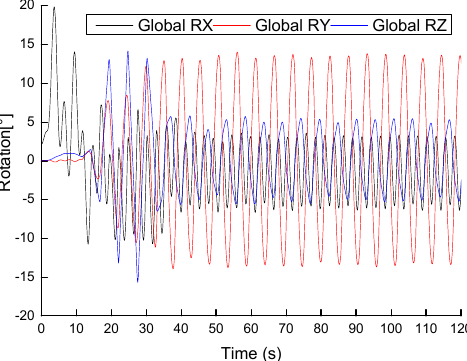
Figure 6. The movement duration of the device in the RX, RY, and RZ directions under the first working condition.